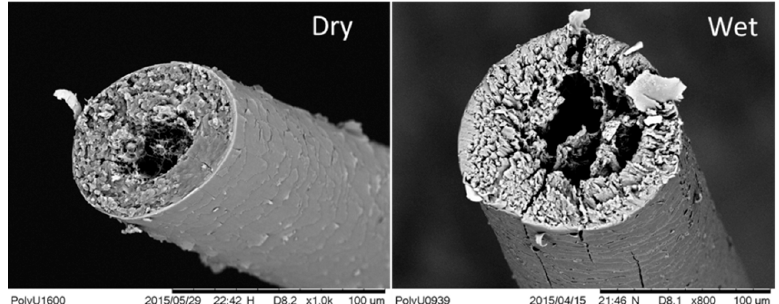
Figure 5. SEM images of cross-sections of goat hair fiber under dry and solvent-wet status.